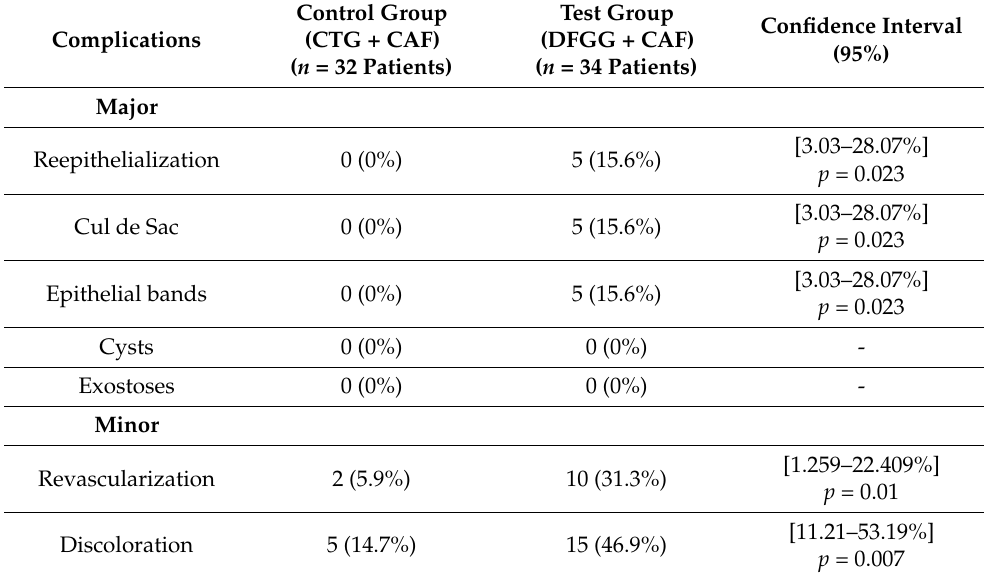
Table 1. Complications observed in the study. Chi square test for independence, with continuity correction or Fisher’s exact